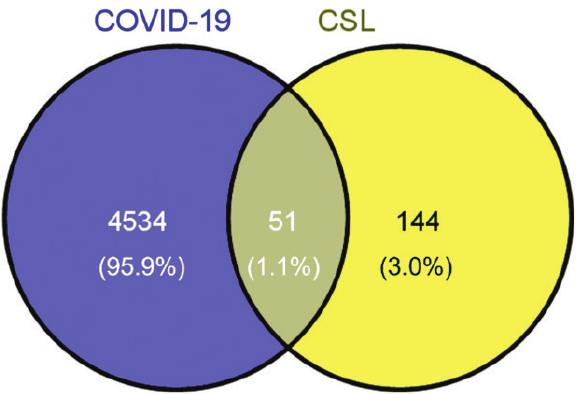
Figure 1. Venn diagram of the potential anti-COVID-19